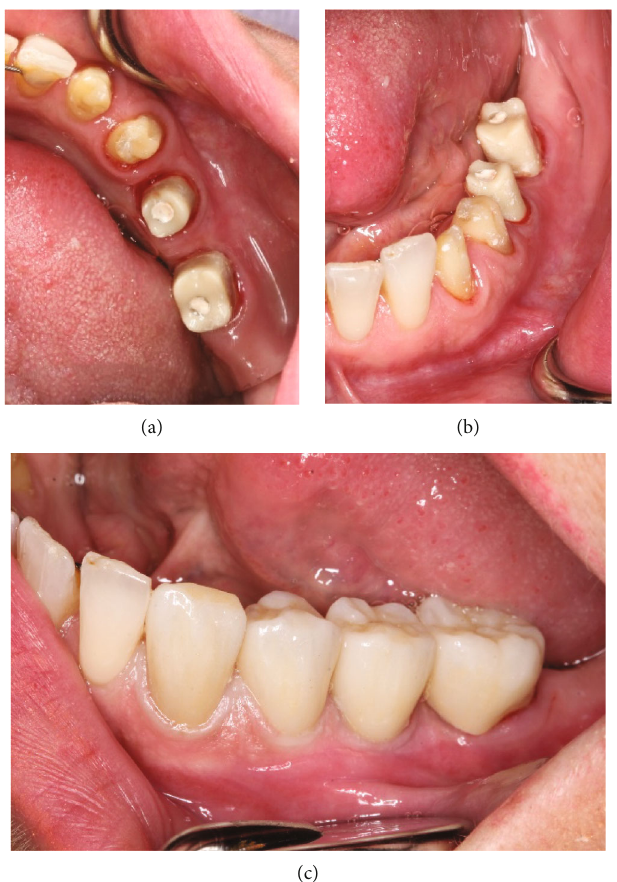
Figure 17: Fitting of the fi nal crowns using dual-curing cement.